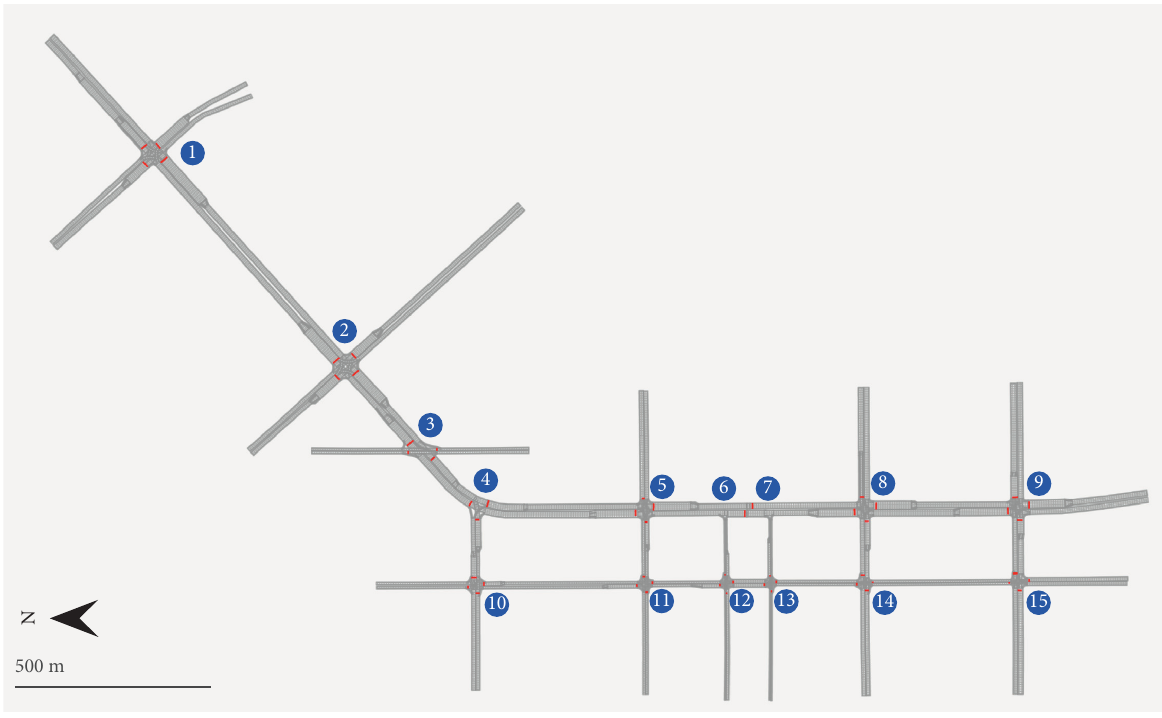
Figure 1: Layout of the road